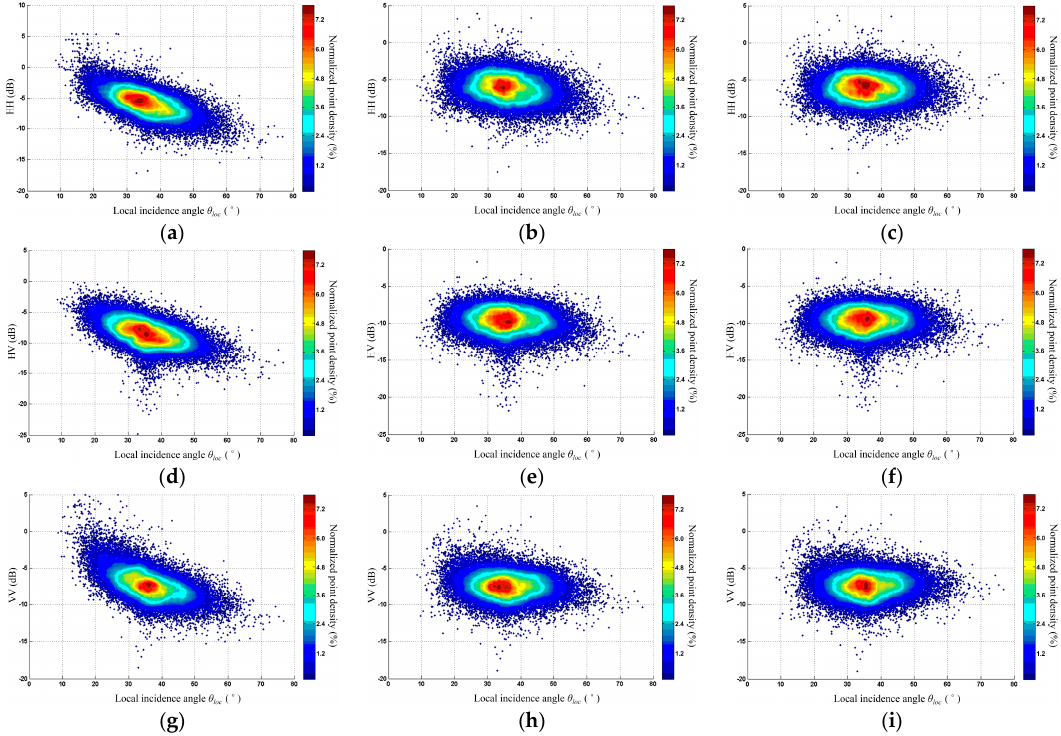
Figure 18. The relationship between backscattering coefficients of different polarisations and local incidence angles: ( a ) HH after POA correction; ( b ) HH after POA + ESA correction; ( c ) HH after POA + ESA + AVE correction; ( d ) HV after POA correction; ( e ) HV after POA + ESA correction; ( f ) HV after POA + ESA + AVE correction; ( g ) VV after POA correction; ( h ) VV after POA + ESA correction; ( i ) VV after POA + ESA + AVE correction.